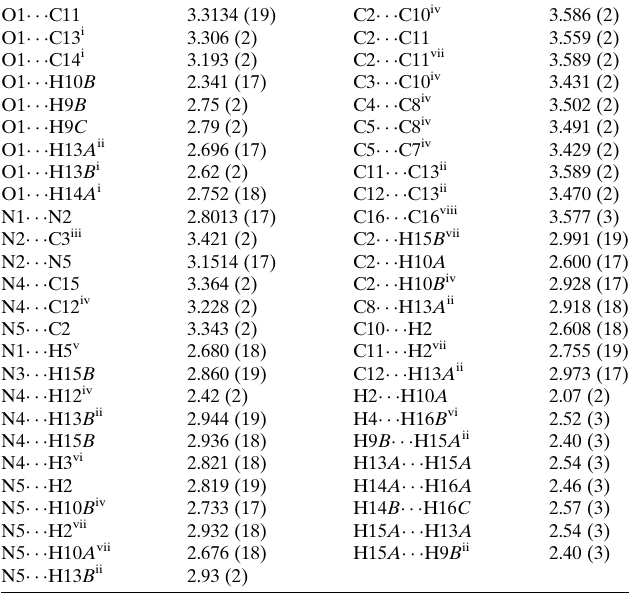
Table 2 Selected interatomic distances (A˚